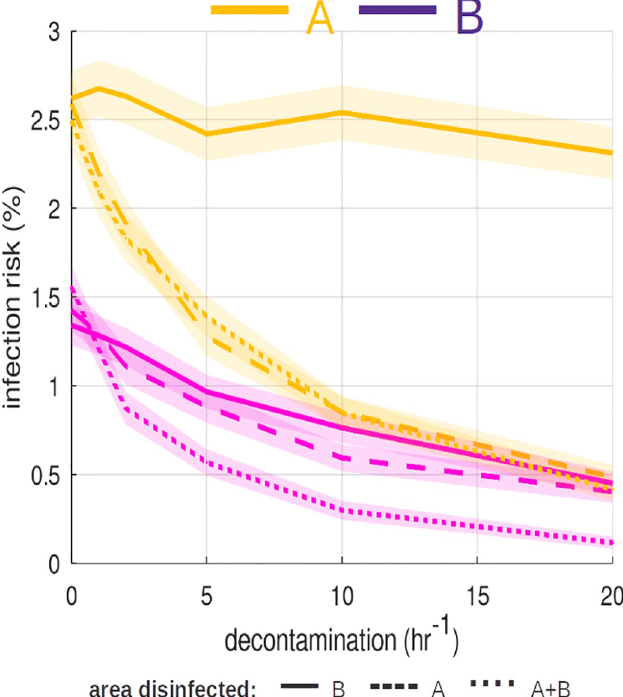
Fig 7. Cleaning/disinfection rates. Average Infection risk (n = 40000 realisations) with 95% CI. Solid lines depict infection risk when cleaning rates applied at location B only. Dashed lines are associated with cleaning at A only. Dotted lines correspond to cleaning rates applied both at A and B . Decontamination at B alone has little impact on the risk to Alice (though a slight decrease is observed at higher cleaning rates as pathogens are prevented coming full-circle back to A from B ). Decontamination at A alone has slightly better outcomes for Bob than cleaning at B alone. This suggests the risk to customers at one location can be subject to hygiene standards and cleaning regimens at another independent